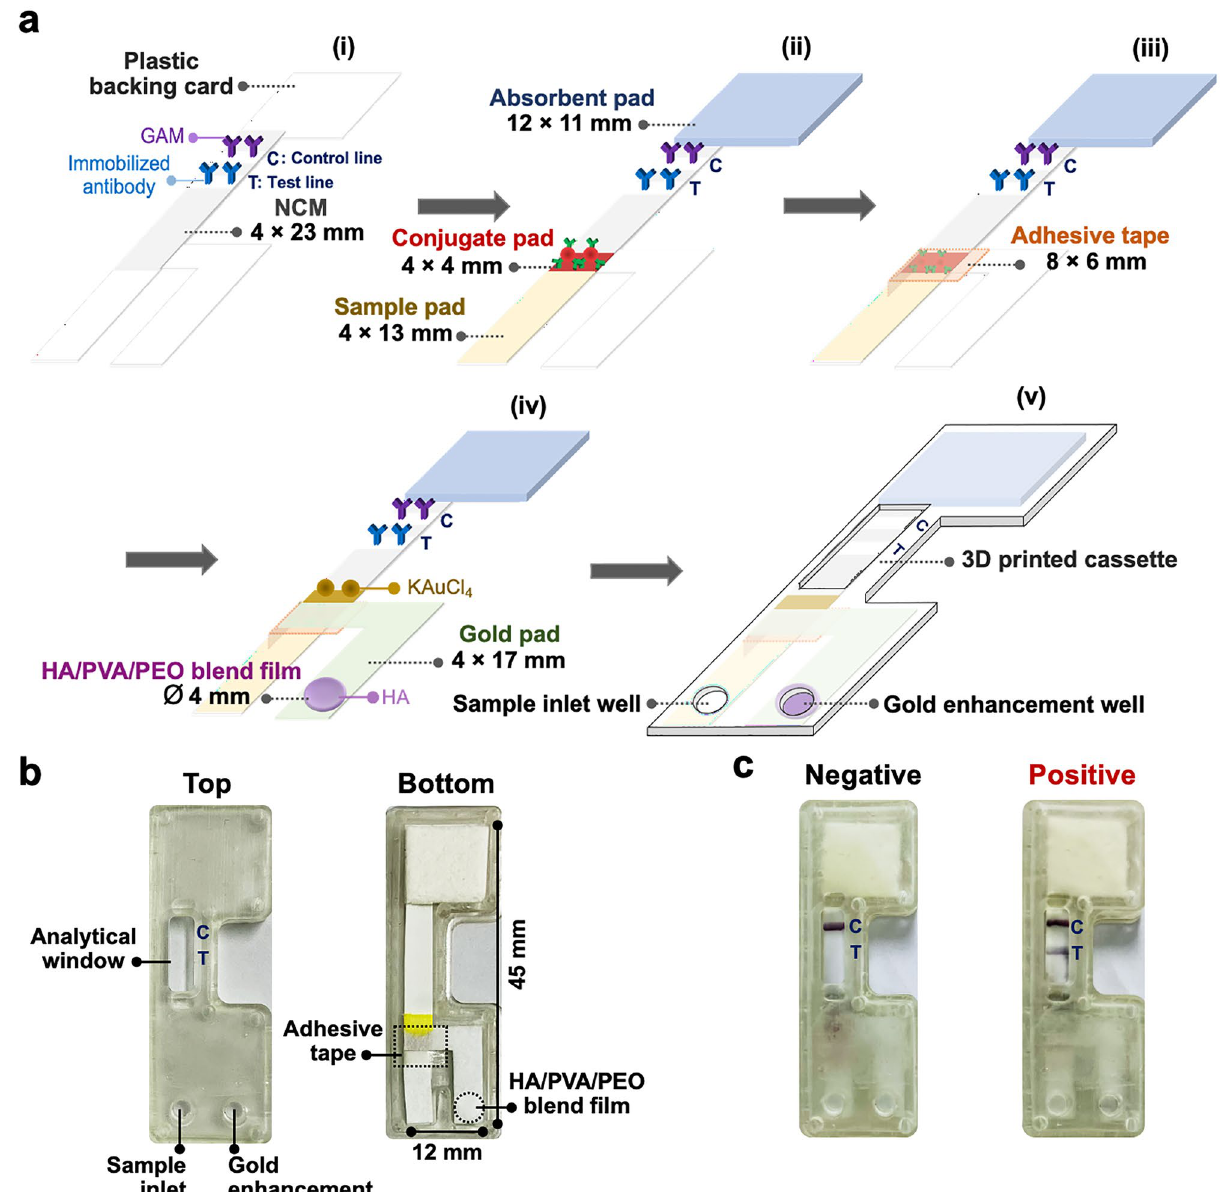
Figure 6. ( a ) Fabrication procedure of the gold enhancement device: (1) preparation and attachment of the NCM on the plastic backing card, (2) preparation and attachment of the conjugate, absorbent and sample pads, (3) attachment of the adhesive tape, (4) preparation and attachment of the gold pad and the HA/PVA/PEO blend film and (5) placement of the device into the 3D printed cassette; ( b ) top and bottom views of the gold enhancement device (12 mm wide and 45 mm long) inside the 3D printed cassette comprising a sample inlet well, a gold enhancement well and an analytical window labeled with letters T and C; ( c ) representative data of negative and positive (20 ng/mL of ferritin) results after gold